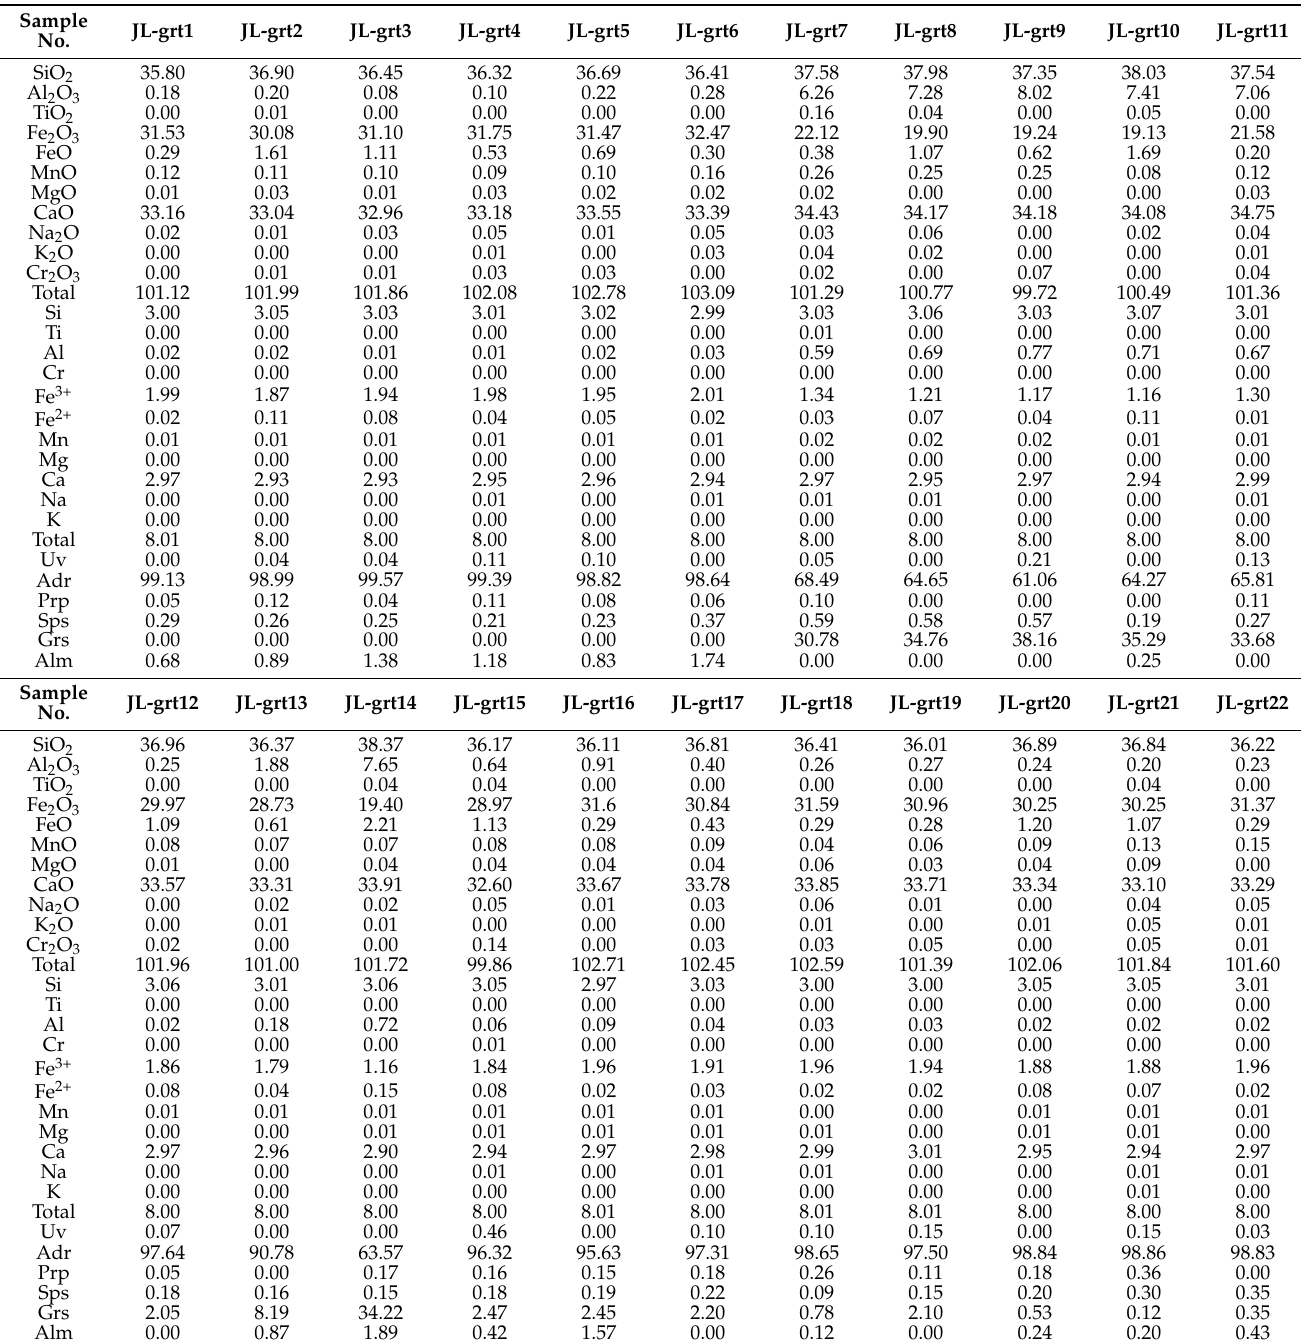
Table 3. EPMA data for garnets from skarn and ore Jinling deposit (JL-grt7–11 from the rim and others from the